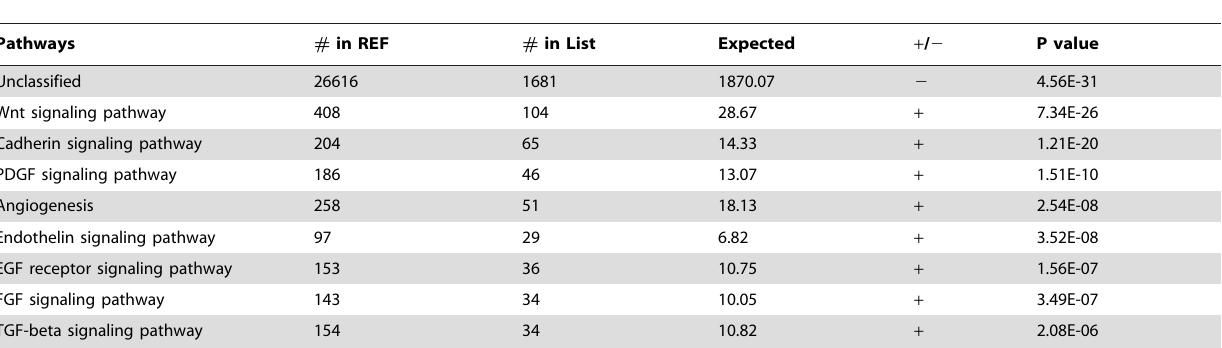
Table 2. Predicted target genes (using TargetScan) for 9 random miRNAs classified by gene pathway ontology.